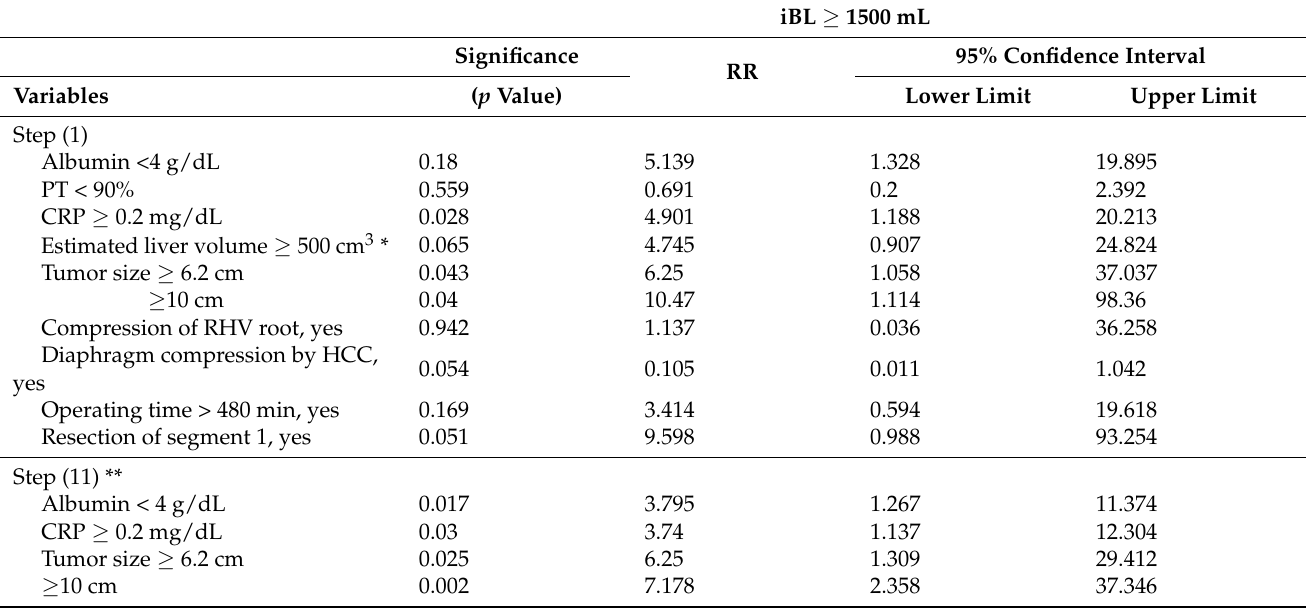
Table 4. Relationship between perioperative continuous or categorical parameters, and increased blood loss (iBL) over 1500 mL in CB through multivariate logistic regression analyses.